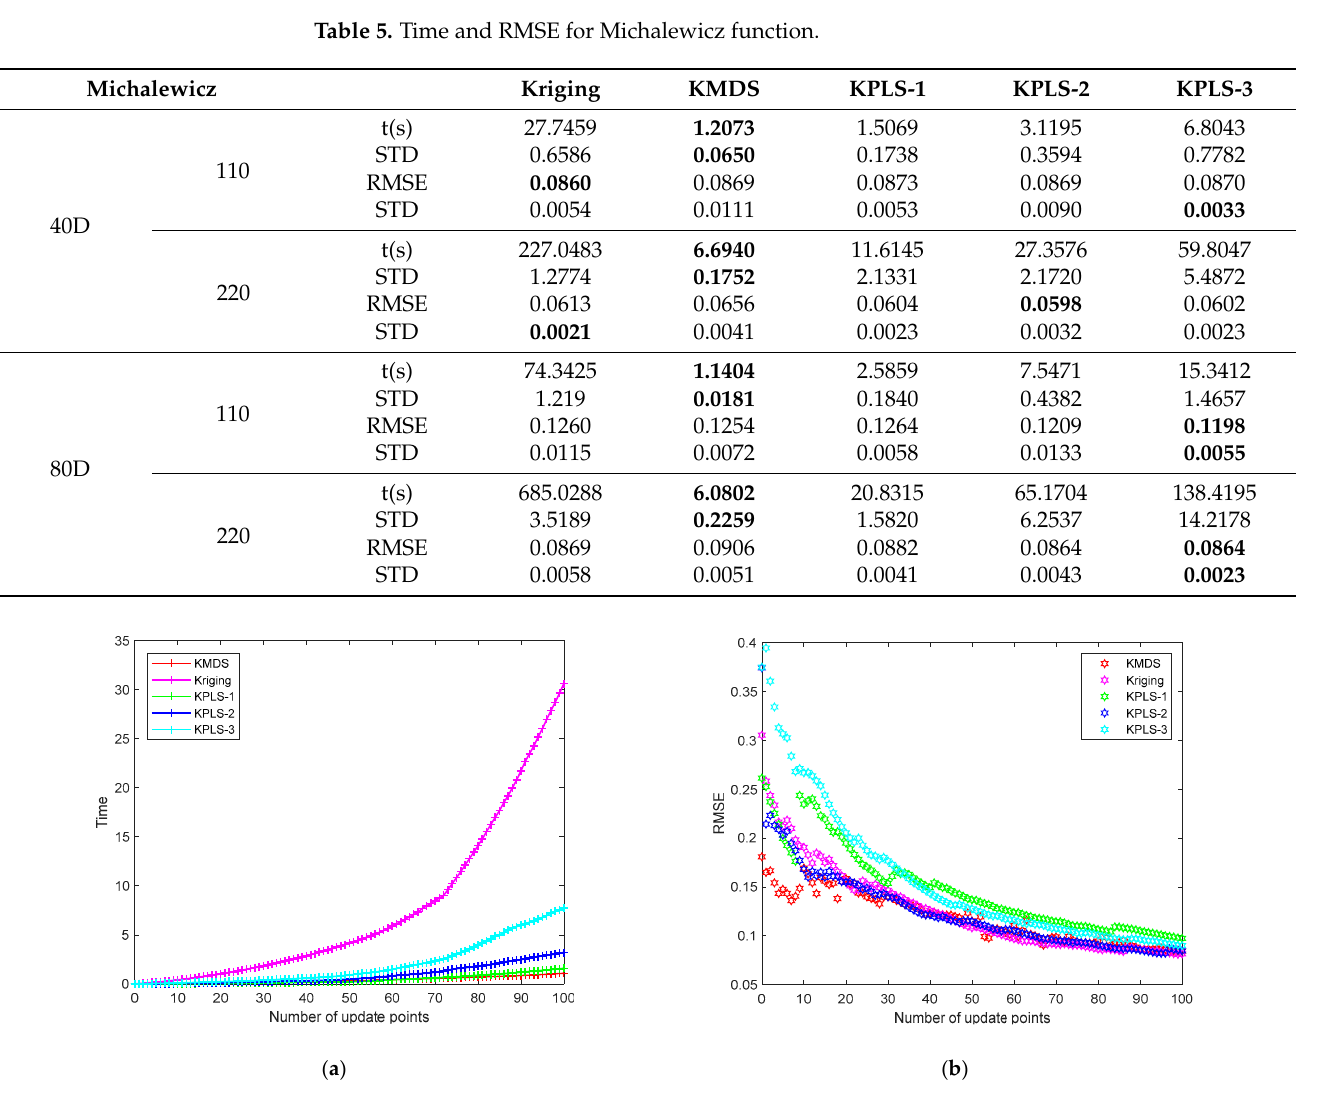
Figure 10. ( a ) The average change trend for the modeling time for the 40D Michalewicz function. ( b ) The average change trend for RMSE for the 40D Michalewicz function.